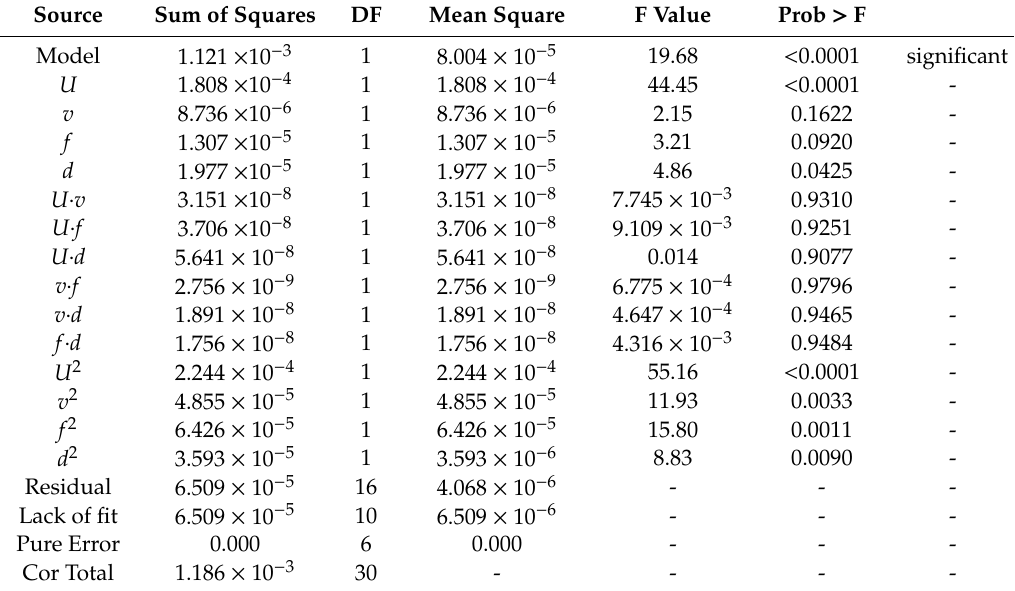
Table 4. Analysis of variance for the material removal amount (MRA).